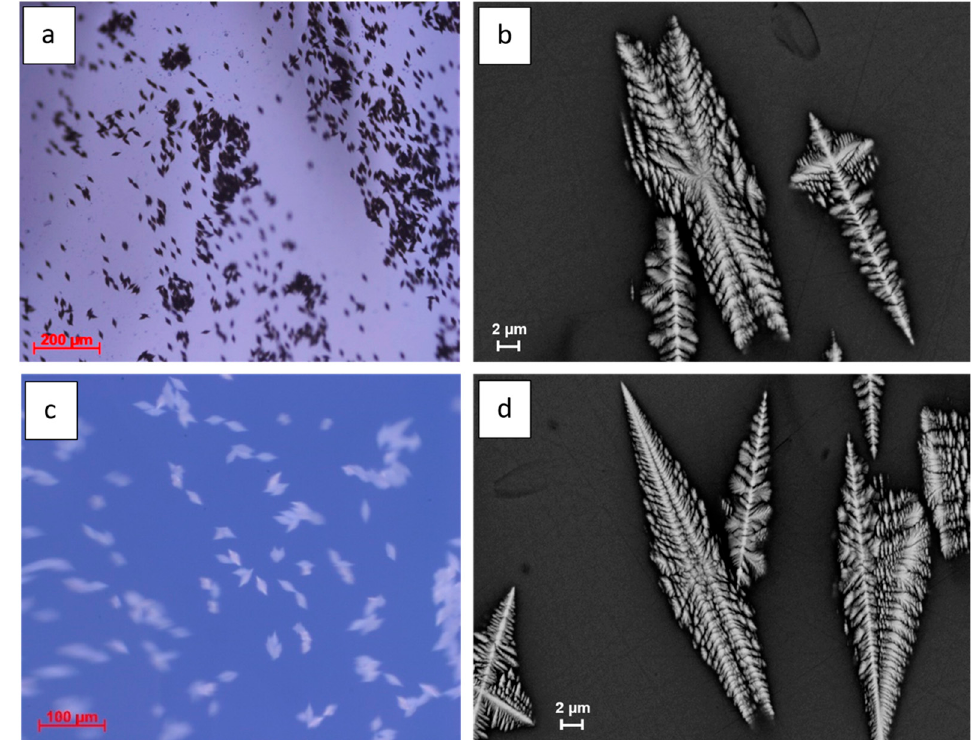
Figure 3. ( a ) Polarized light image and ( b ) SEM image (magnification 2000×) of subparallel layers of microinclusions in a sample of the initial BaNaNS glass. ( c ) Crossed polarized light image with converging lens and ( d ) SEM image (magnification 2000×) of a random multidomain nanostructured BaNaNS glass (heat program (2)). In ( c ), the glass matrix is clearly blue, whereas the solid inclusions are white.